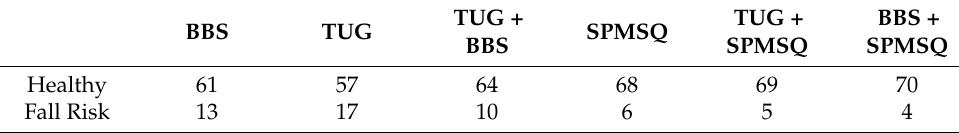
Table 2. Label distribution of all subjects for each clinical test.